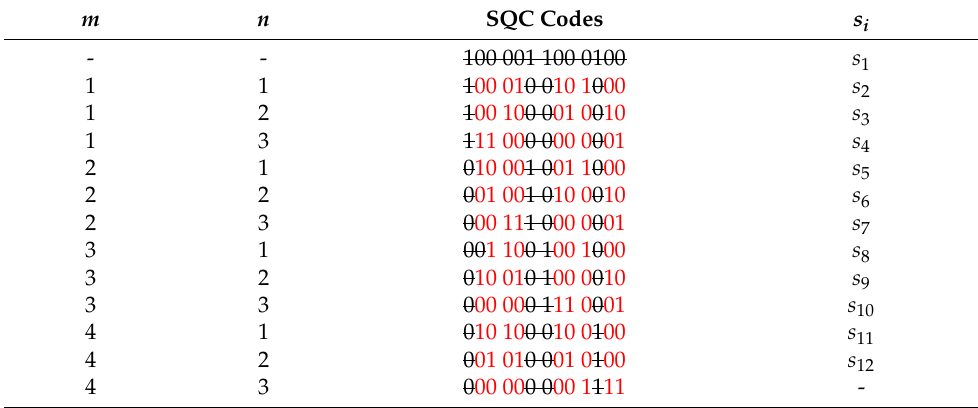
Table 1. Demonstration of RSQC code construction ( w = 3 and N = 9) from a SQC matrix. m n SQC